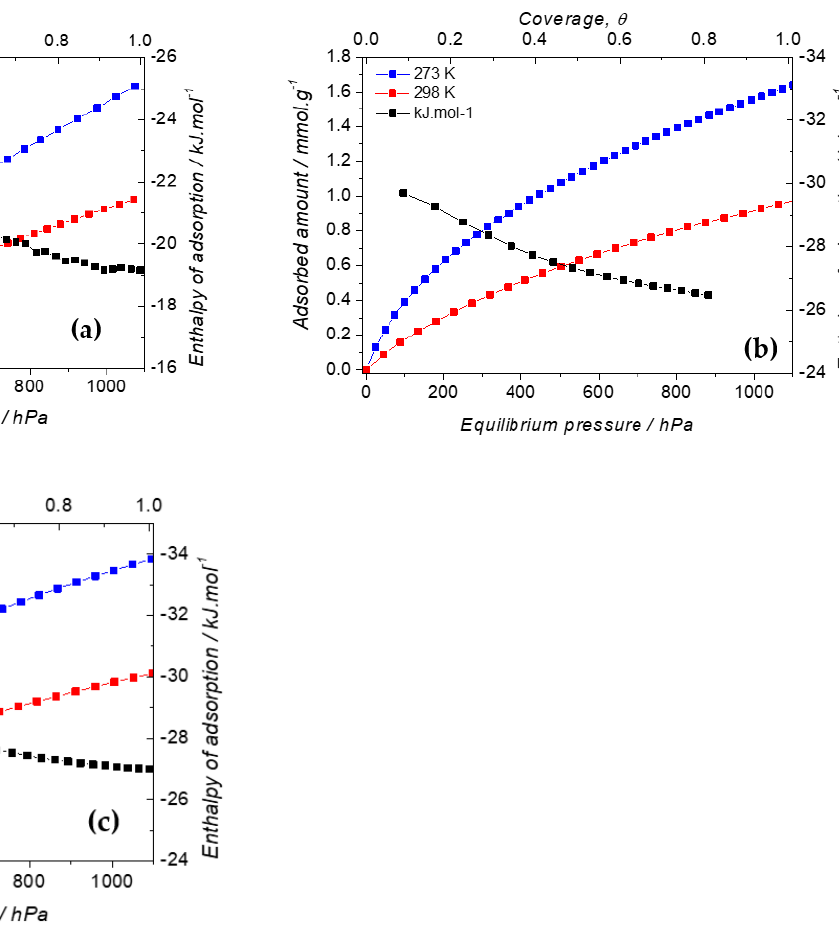
Figure 17. Isosteric heat of adsorption for the selected PMOs: ( a ) pyPMO 15; ( b ) iPrbipy PMO 6; ( c ) EtbipyPMO 15. The maximum coverage, θ, has been defined as the ratio between the adsorbed amount and the adsorbed amount taken at 10 5 Pa.